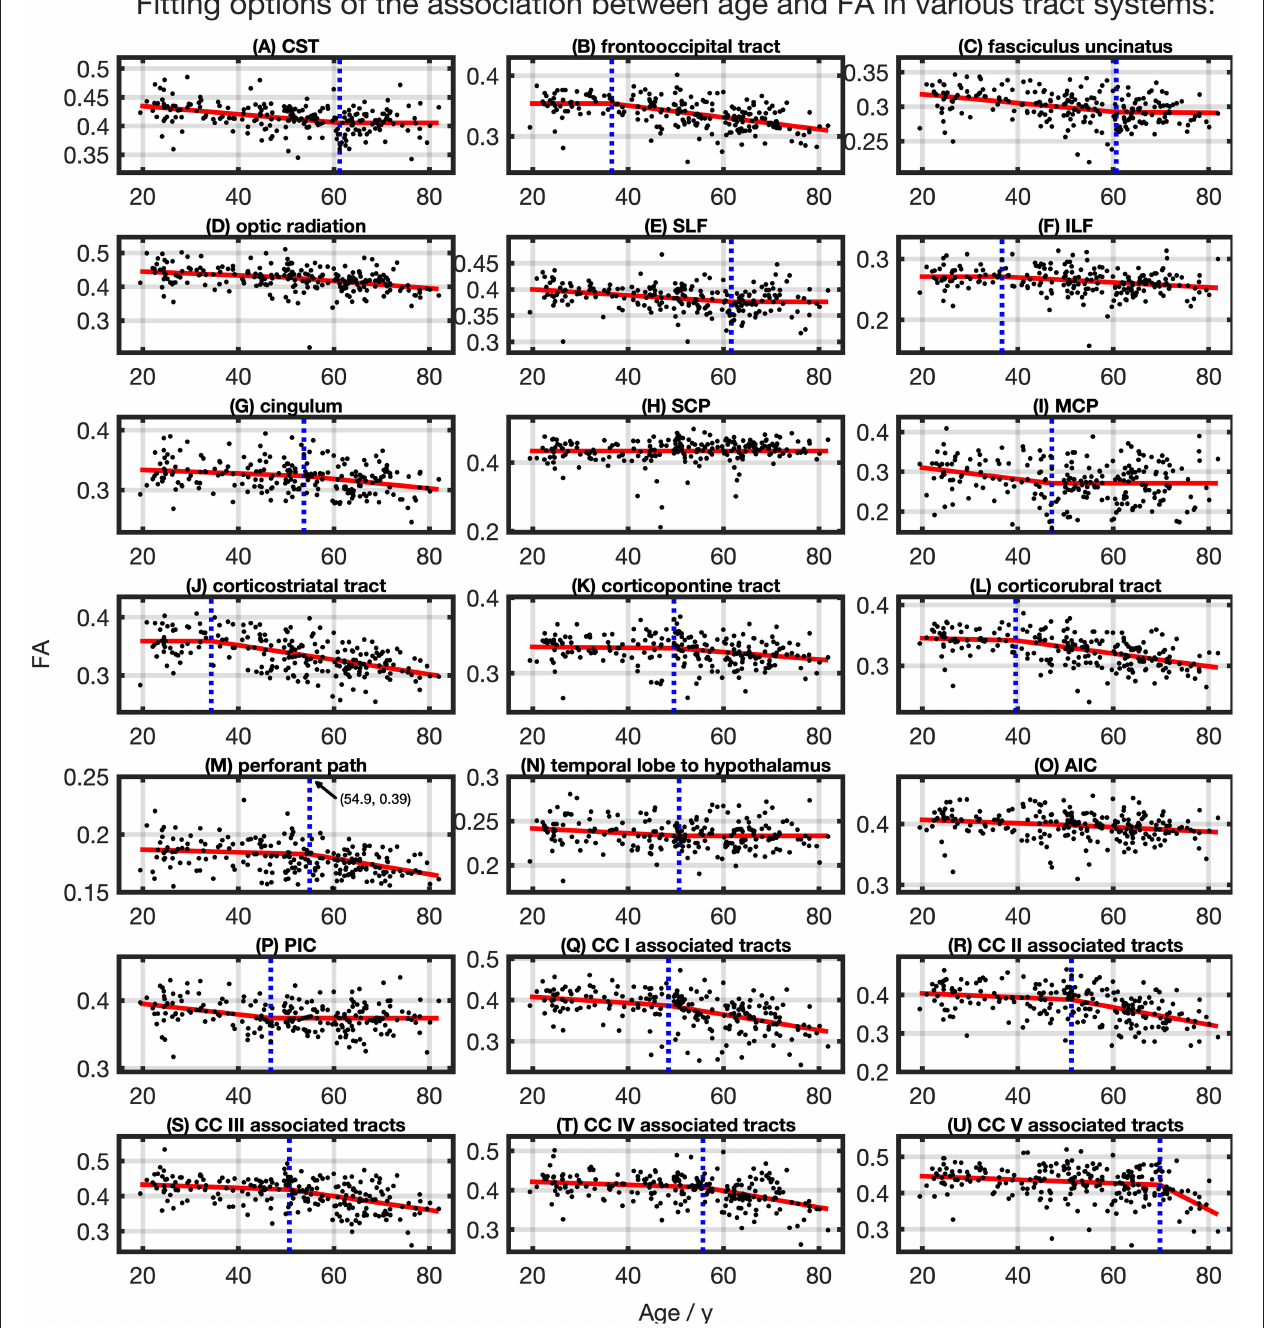
FIGURE 4 | Scatter plots (black) and regression line (red) of the association between age and FA in various tract systems. The fit shown in each case is the one with the highest adjusted R 2 . (D,H,O) One linear regression across age span. (A–C,E–G,I–N,P–U) In all other tract systems, data were fitted with linear splines. The position of the knot between two linear curve segments is given as a blue dashed line (CC, corpus callosum; CST, corticospinal tract; SLF, superior longitudinal fasciculus; ILF, inferior longitudinal fasciculus; SCP, superior cerebellar peduncle; MCP, middle cerebellar peduncle; AIC, anterior limb of internal capsule; PIC, posterior limb of internal